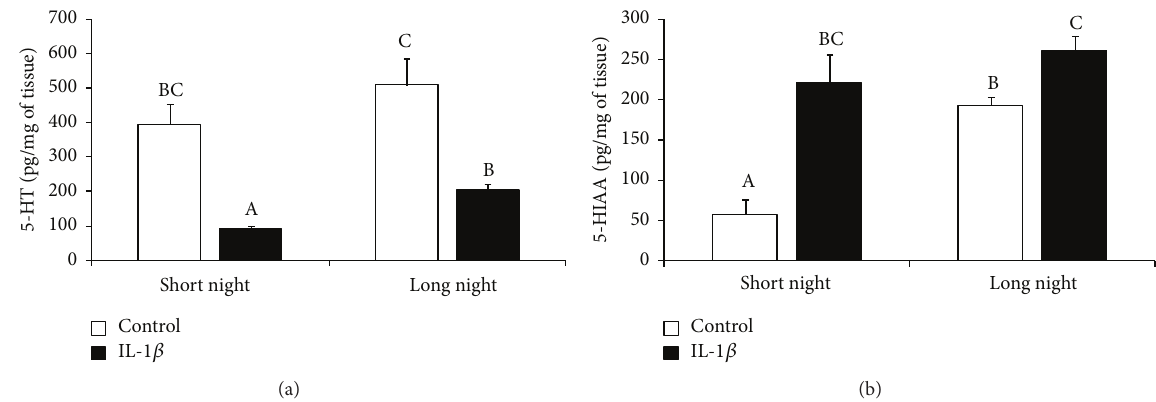
Figure 4: The effects of intracerebroventricular injection of interleukin- (IL-) 1 𝛽 (50 𝜇 g/animal) or Ringer’s solution (50 𝜇 L) on the mean ( ± SEM; 𝑛 = 6 animals per group) concentration of serotonin (5-HT; (a)) and its metabolite 5-hydroxyl-indole-3-acetic acid (5-HIAA; (b)) in the pineal gland collected from control and IL-1 𝛽 -treated ewes during the short night (SN, May/June) and long night (LN, November/December) photoperiods. Different capital letters indicate significant ( 𝑃 < 0.05 ) differences according to a two-way ANOVA followed by Tukey’s post hoc